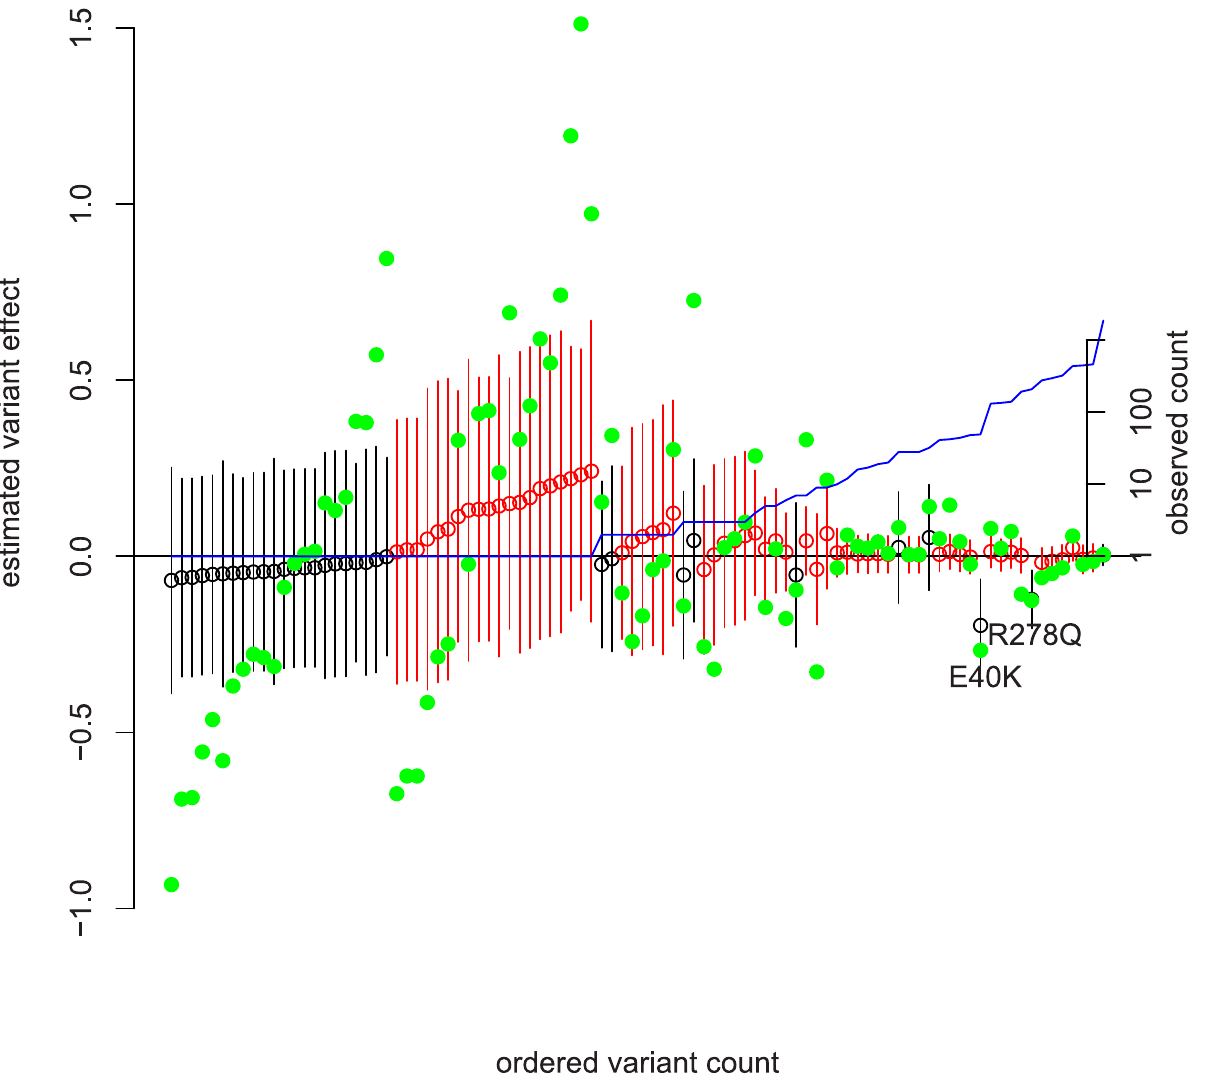
Figure 3. Frequency versus estimated effect size in ANGPTL4 with ordinary least squares estimates. The SNPs have been rank-ordered by observed frequency on the x-axis with ties broken by estimated effect size. The left y-axis is the predicted effect ( ^ cc j in (4) ) on the log of serum triglycerides. Green solid dots are the point estimate for each variant’s effect on log-triglycerides from one variant at a time ordinary least squares adjusted for non-genetic covariates. Open circles are joint point estimates of ^ cc from our method, and bars 95% prediction intervals on those estimates. Confidence intervals are the elementwise Wald-type estimates described in chapter 6 of [37] and produced by SAS’s estimate command in the mixed procedure. See Text S1 for the calculation of point estimates, and the sample code at the author’s website for SAS commands. Non- synonymous variation is in black; non-coding variation in red. The right y-axis and blue line depict observed count pooled across ethnicities on a log